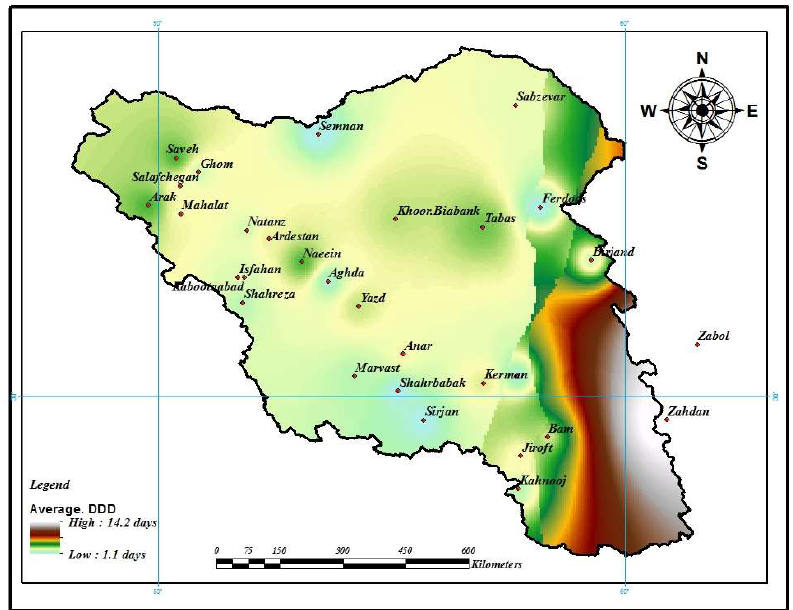
Figure 9. Map of the average annual-maximum dust day duration in the study area. According to Figure 9, DDD is maximum in the east and southeast of the study area. Additionally, Saveh and Arak stations in the northwest of the region have a relatively high DDD.